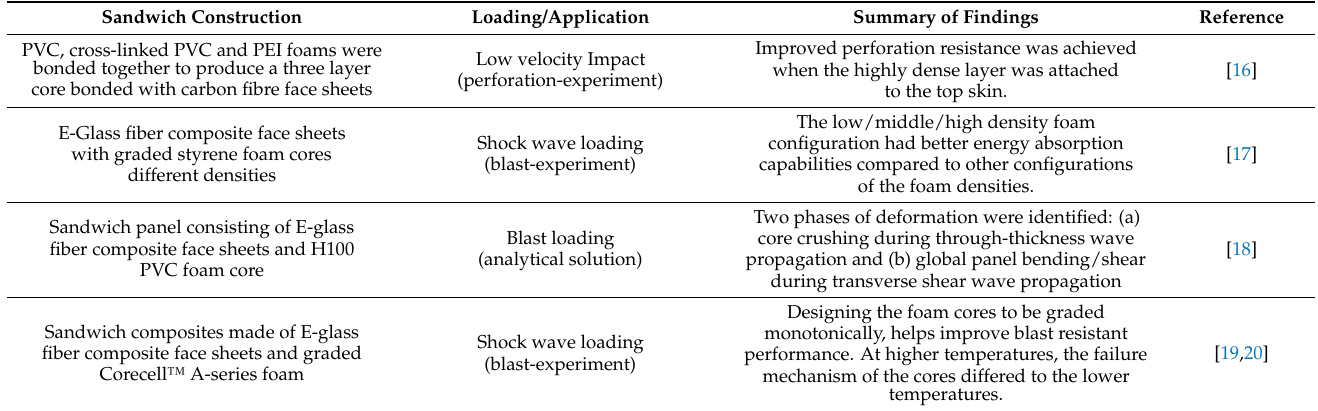
Table 1. Sandwich structure with polymeric foam